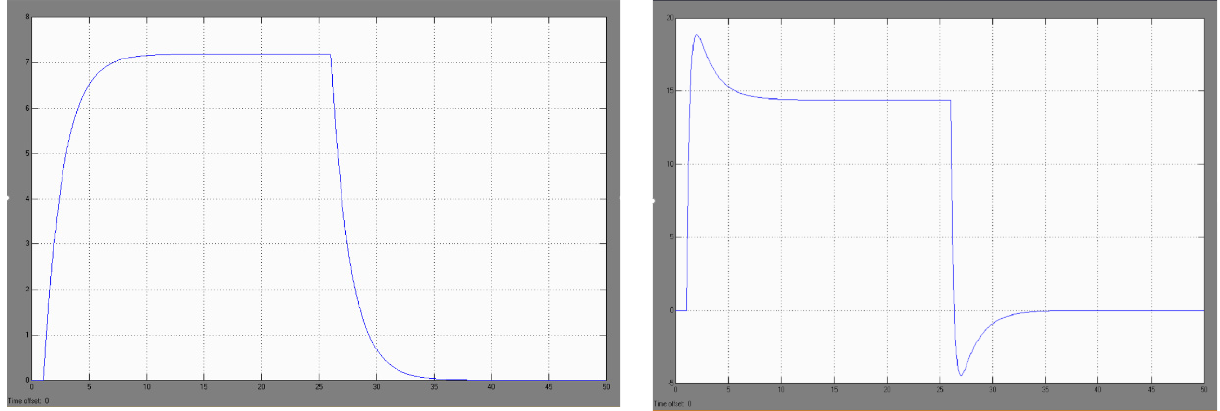
Figure 8. The modeled signal of the thermoelectric sensor after its sudden heating, and subsequent cooling for the DPS sensor ( left ) and for the DTBG sensor ( right ).